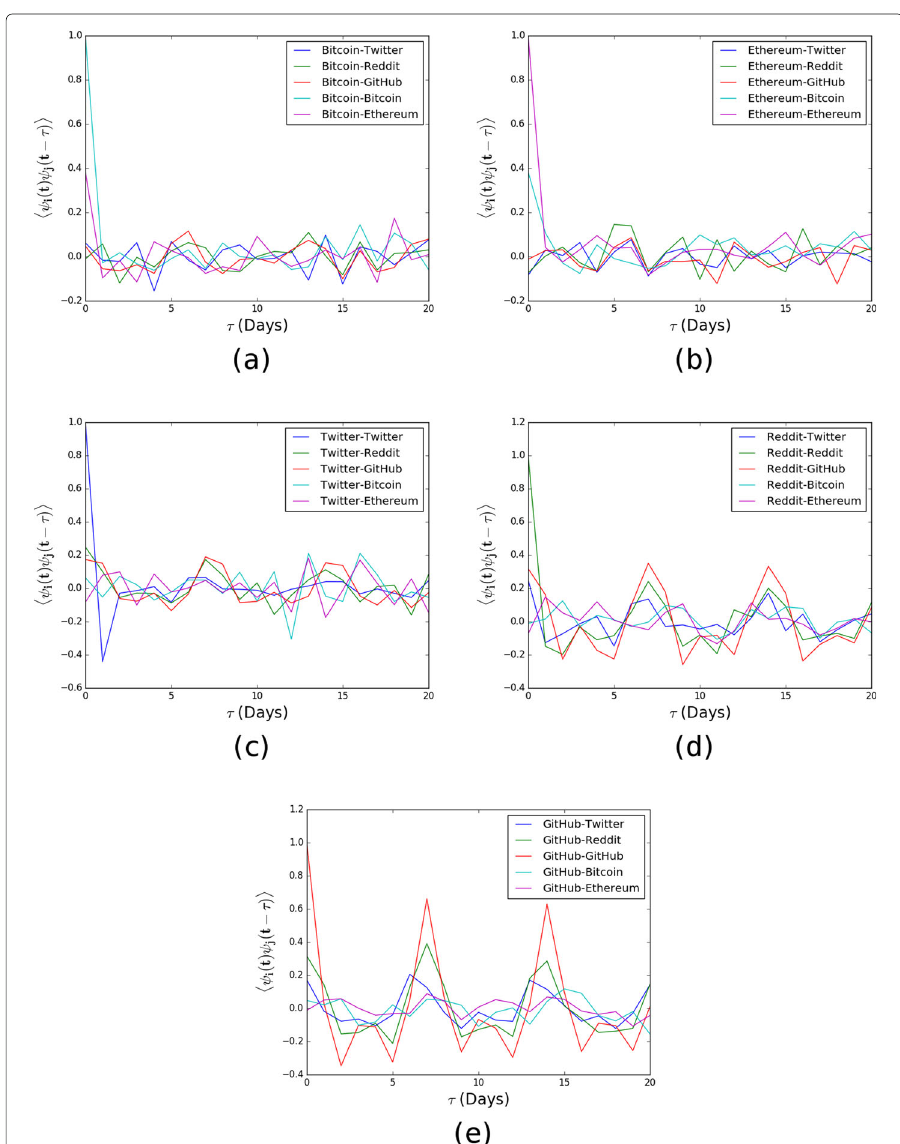
Fig. 9 The temporal correlation of noise variables for fixed ( a ) Bitcoin, ( b ) Ethereum, ( c ) Twitter, ( d ) Reddit, and ( e ) GitHub using 242 days. Here, each time series is shifted by a number of days τ and the correlation coefficient is